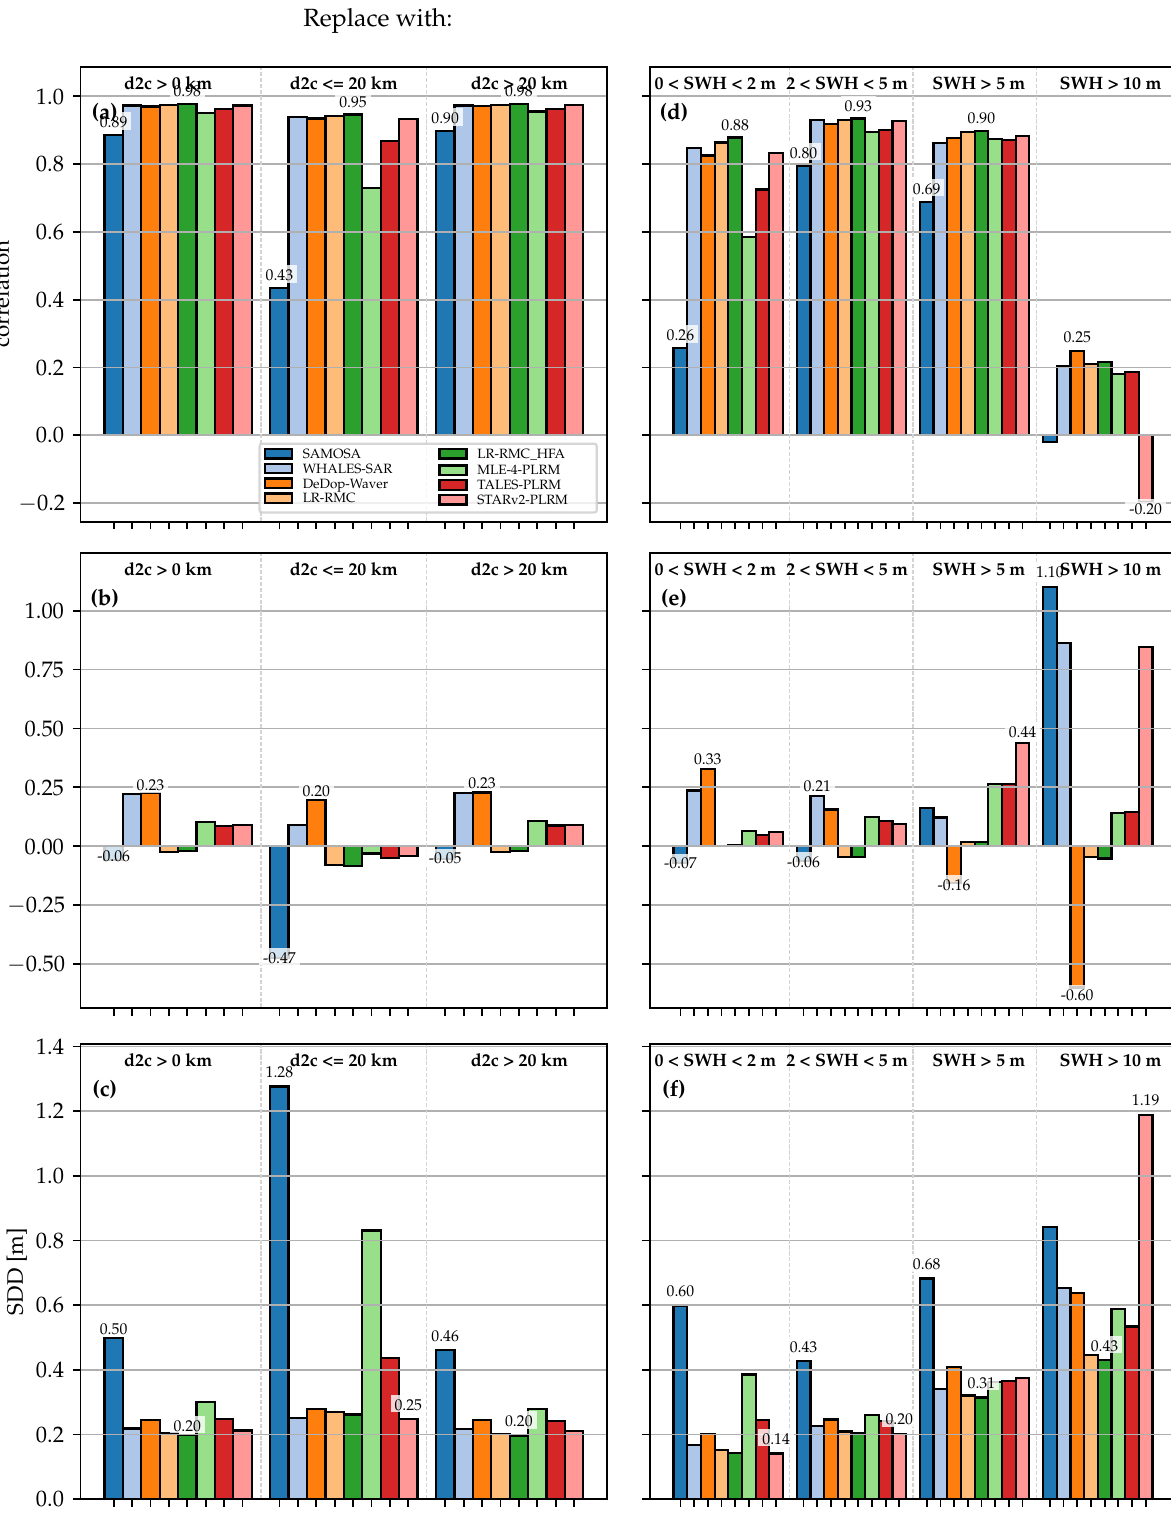
Figure 10. Comparison of the ( a / d ) correlation coefficient, ( b / e ) median bias, ( c / f ) SDD against ERA5-h model of the individual Sentinel-3A (S3A) retrackers as a function of dist2coast and of SWH, respectively. (Revision of original Figure